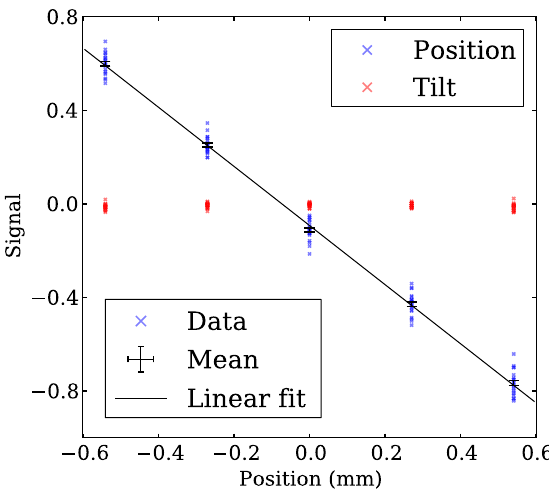
FIG. 15. Fit of vertical position signal amplitude against the predicted beam position to measure the position scale factor. The tilt signal from the bunch tilt and beam trajectory angle is also